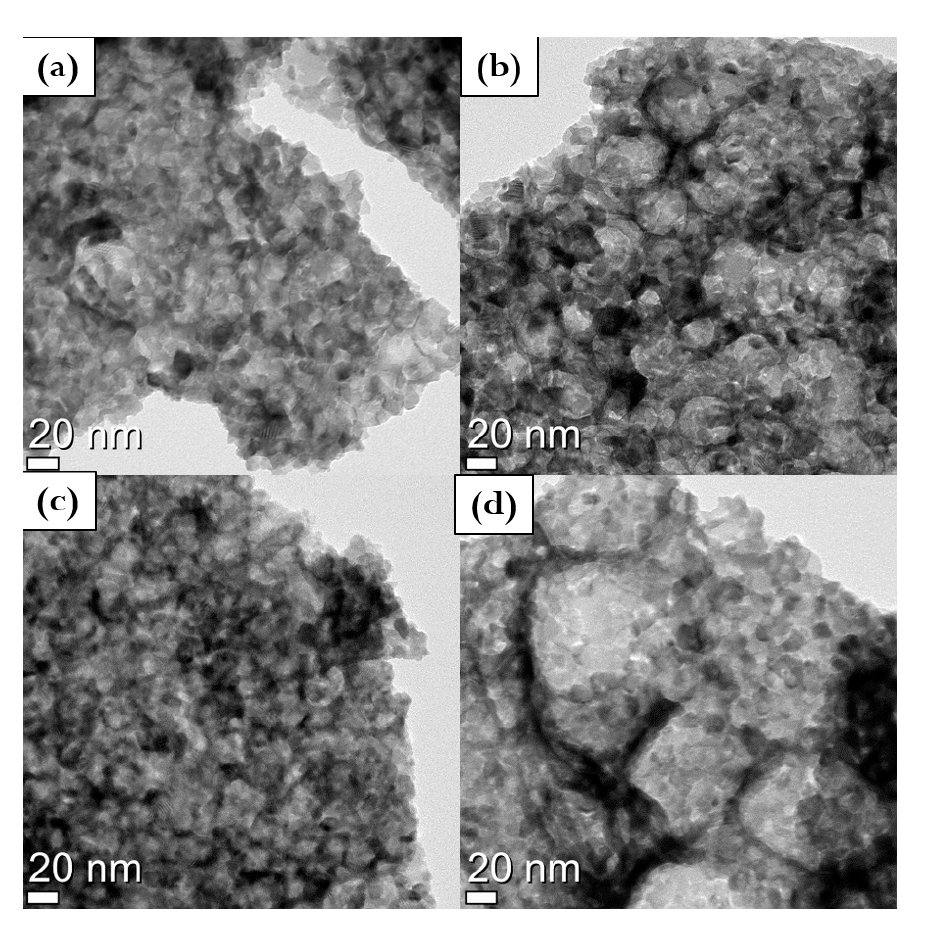
Figure 2. TEM micrographs of ( a ) pure GDC, ( b ) 0.5 Cu, ( c ) 1 Cu, and ( d ) 2 Cu calcined powders.